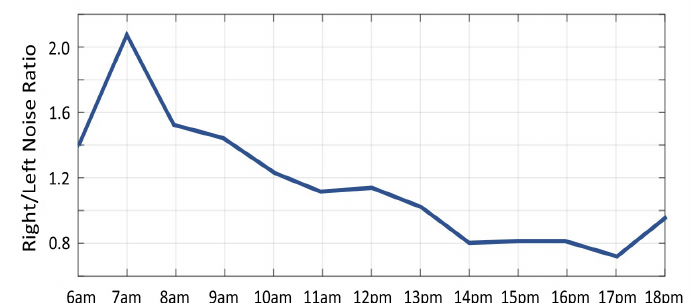
Figure 14. The noise ratio between right and left sides of the face plotted per hour.